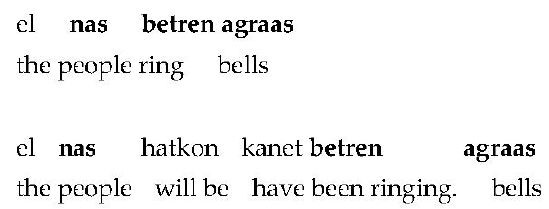
Figure 7. English stress-timed rhythm.